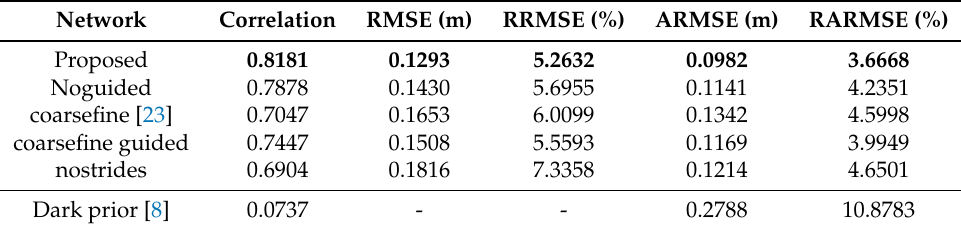
Table 3. Results of different neural network architectures using all the datasets.